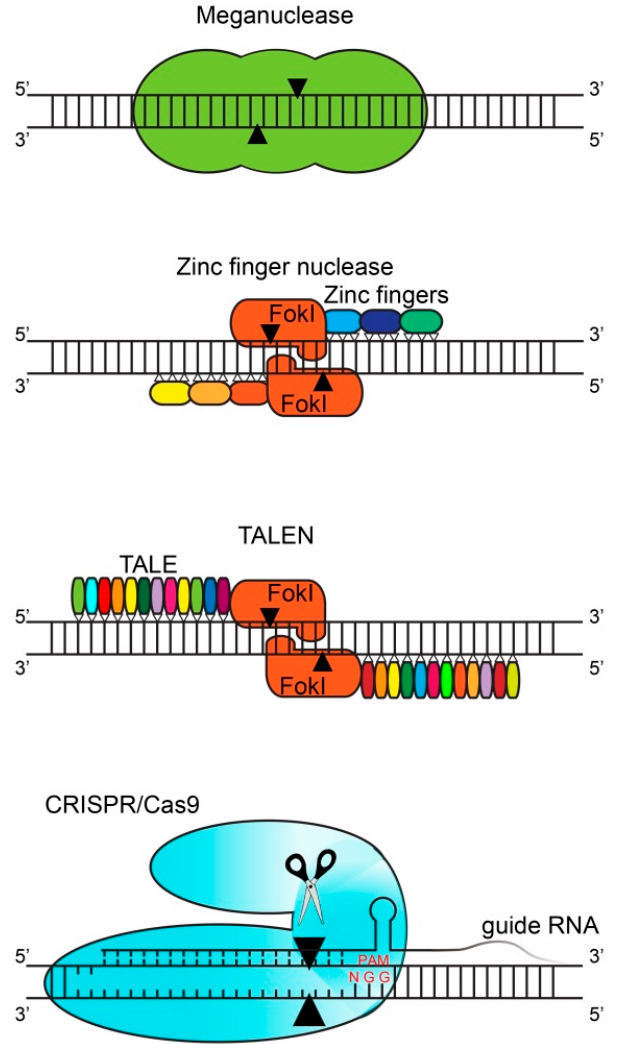
Figure 1. Gene editing techniques. Overview of the different gene editing designer nucleases. This figure depicts the initially discovered meganucleases. In addition, the zinc finger and transcription activator-like effectors (TALE) are depicted, which are fused to Fokl nuclease monomers which cleave the DNA upon dimerization. Each DNA-binding module is indicated with a different color. The most recently discovered RNA-guided clustered regularly interspaced short palindromic repeats (CRISPR)/CRISPR associated proteins-9 (Cas9) system is illustrated as well. Black arrows represent the cleavage site.